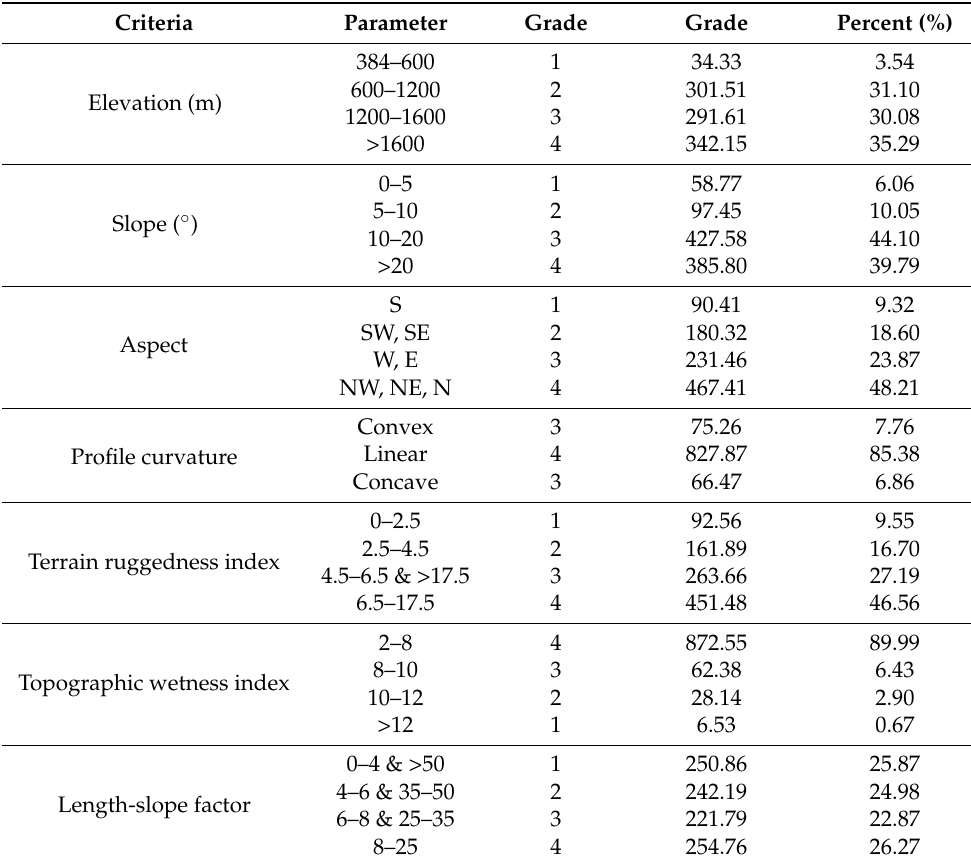
Table 7. Assessment of geomorphological conditions.